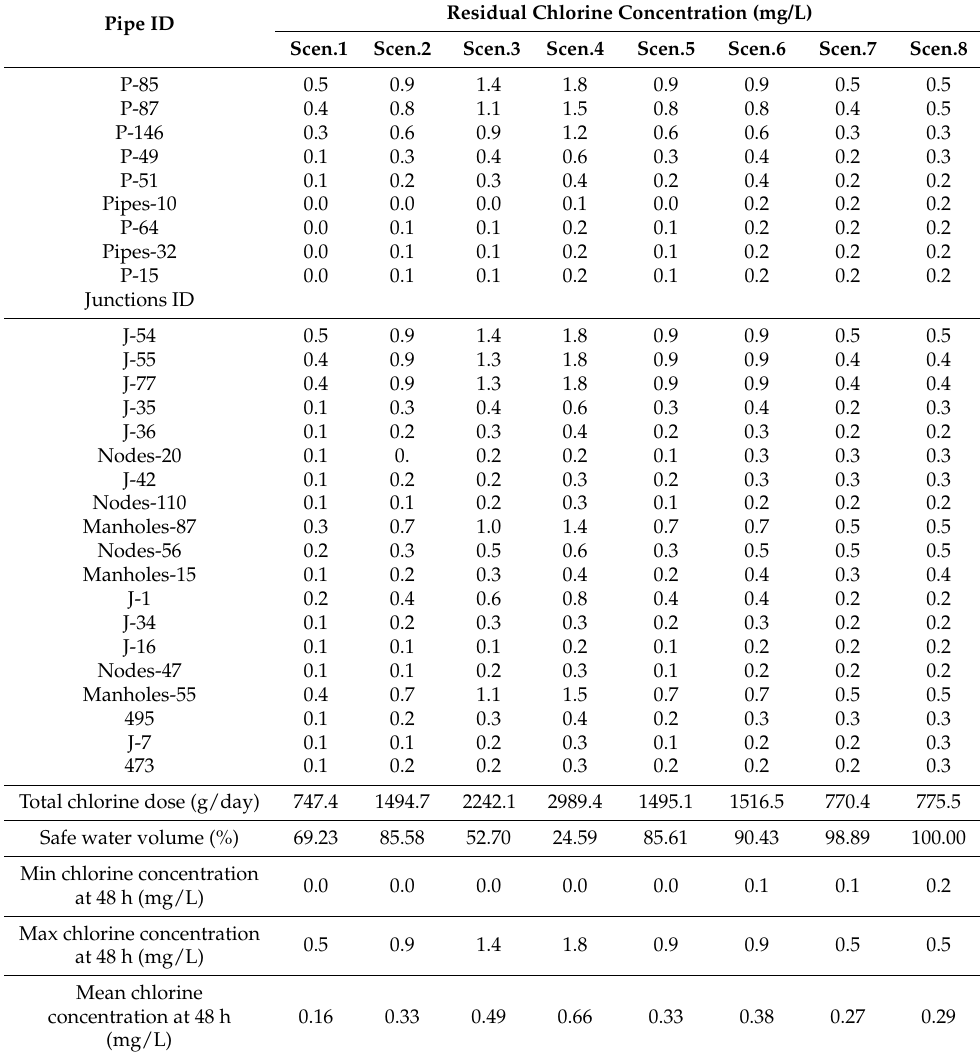
Table 6. Chlorine residual concentrations at selected pipes and nodes for scenario